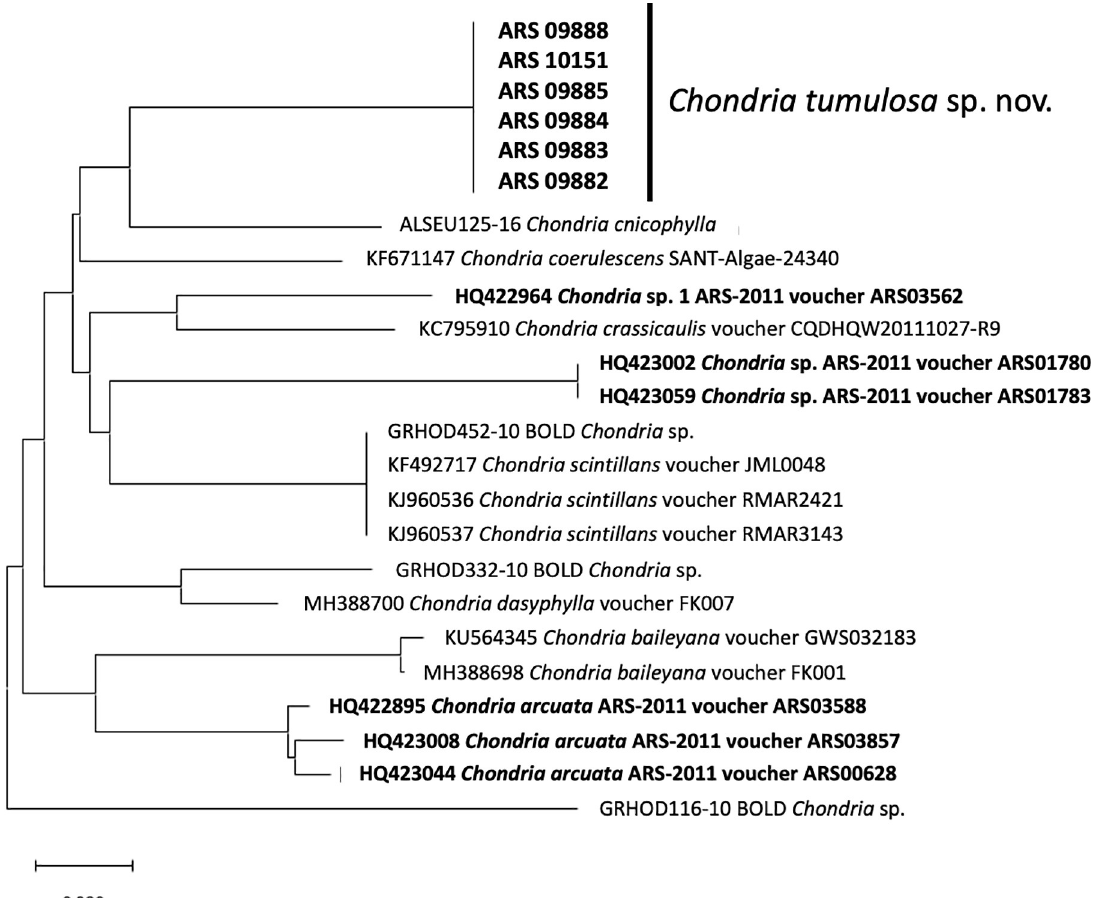
Fig 1. Neighbor-joining phylogram (K2P distances) of COI sequences of Chondria . The phylogram analysis demonstrates the sequence divergence of C . tumulosa sp. nov. samples from other represented members of the genus, and illustrates that the newly analyzed specimens from Pearl and Hermes Atoll do not match previously characterized specimens in the genus. Additional Hawaiian specimens are shown in bold. Scale bar = substitutions per site.